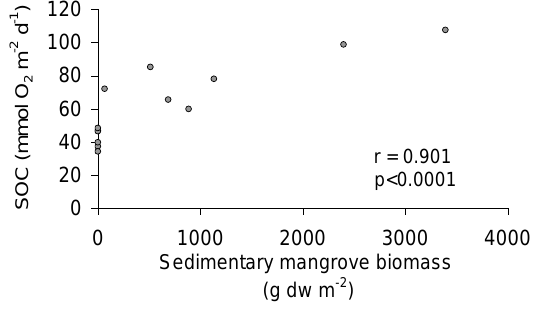
Fig. 6. Relationship between SOC (mmol O 2 m − 2 d − 1 ) and sedi- mentary mangrove biomass (gdwm − 2